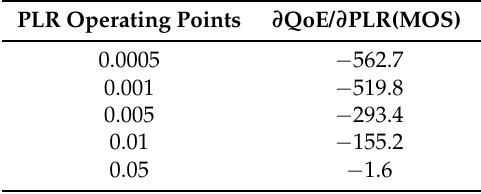
Table 2. First derivative of QoE w.r.t PLR at operating points.